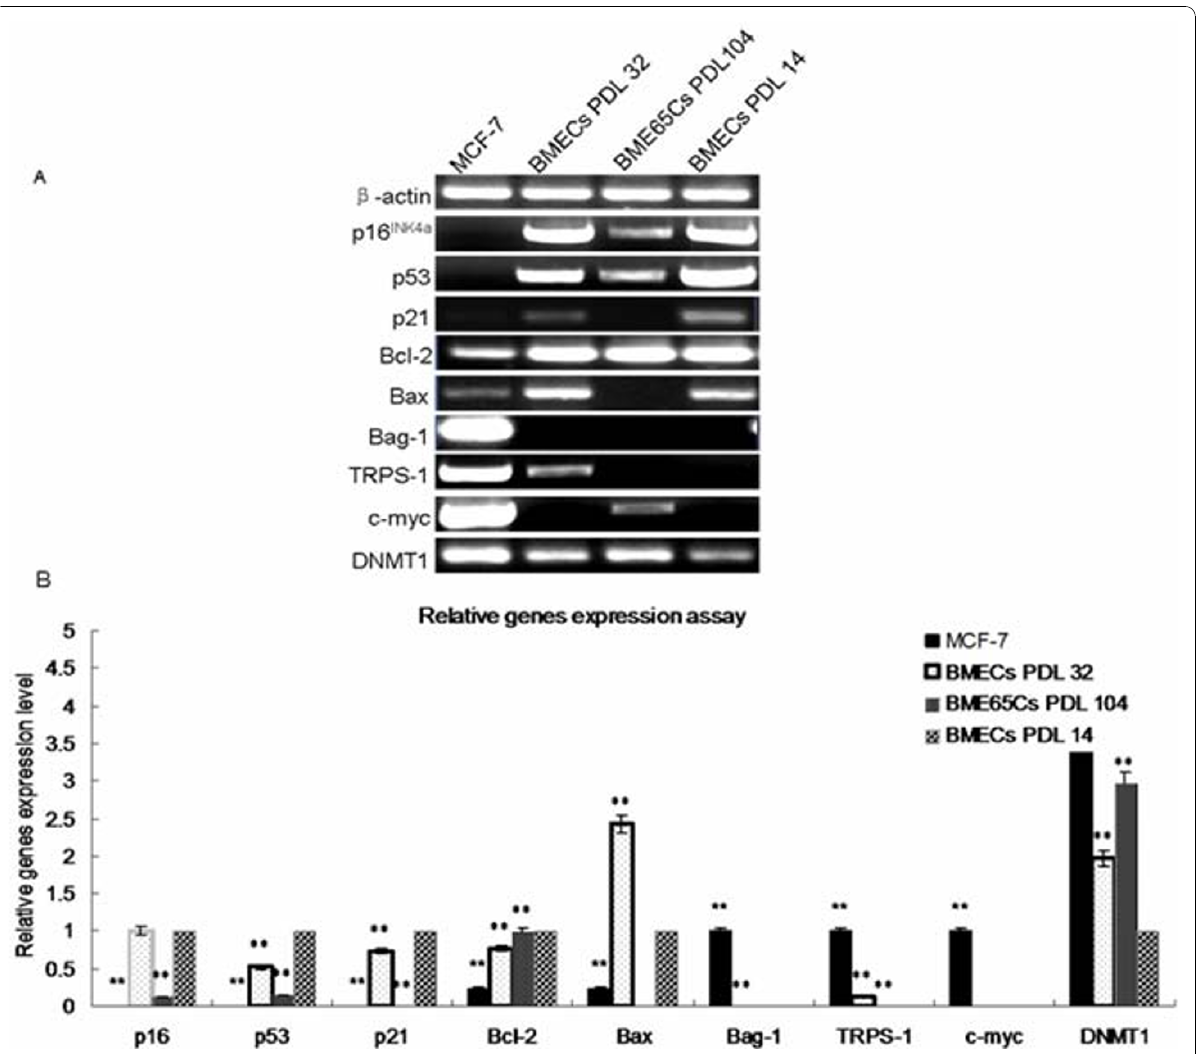
Figure 6 Relative genes expression of early passage senescent BMECs, BME65Cs and MCF-7 cells . A . The detection of relative genes expression by RT-PCR. B . Analysis of expression level by gray scale. The expression level of each gene in BMECs cells (PDL 14) was set to 1.0. The expression level for TRPS-1 , Bag-1 and c-Myc in MCF-7 cells was set to 1.0 because these three genes expressions were not detected in BMECs cells (PDL 14)]. Other samples were adjusted accordingly. All PCR products were confirmed by sequencing. Gray scale analysis is from at least 3 independent experiments. *: P < 0.05 compared to BMECs cells passage 14 (Student ’ s t-test). **: P < 0.01 compared to BMECs cells passage 14 (Student ’ s